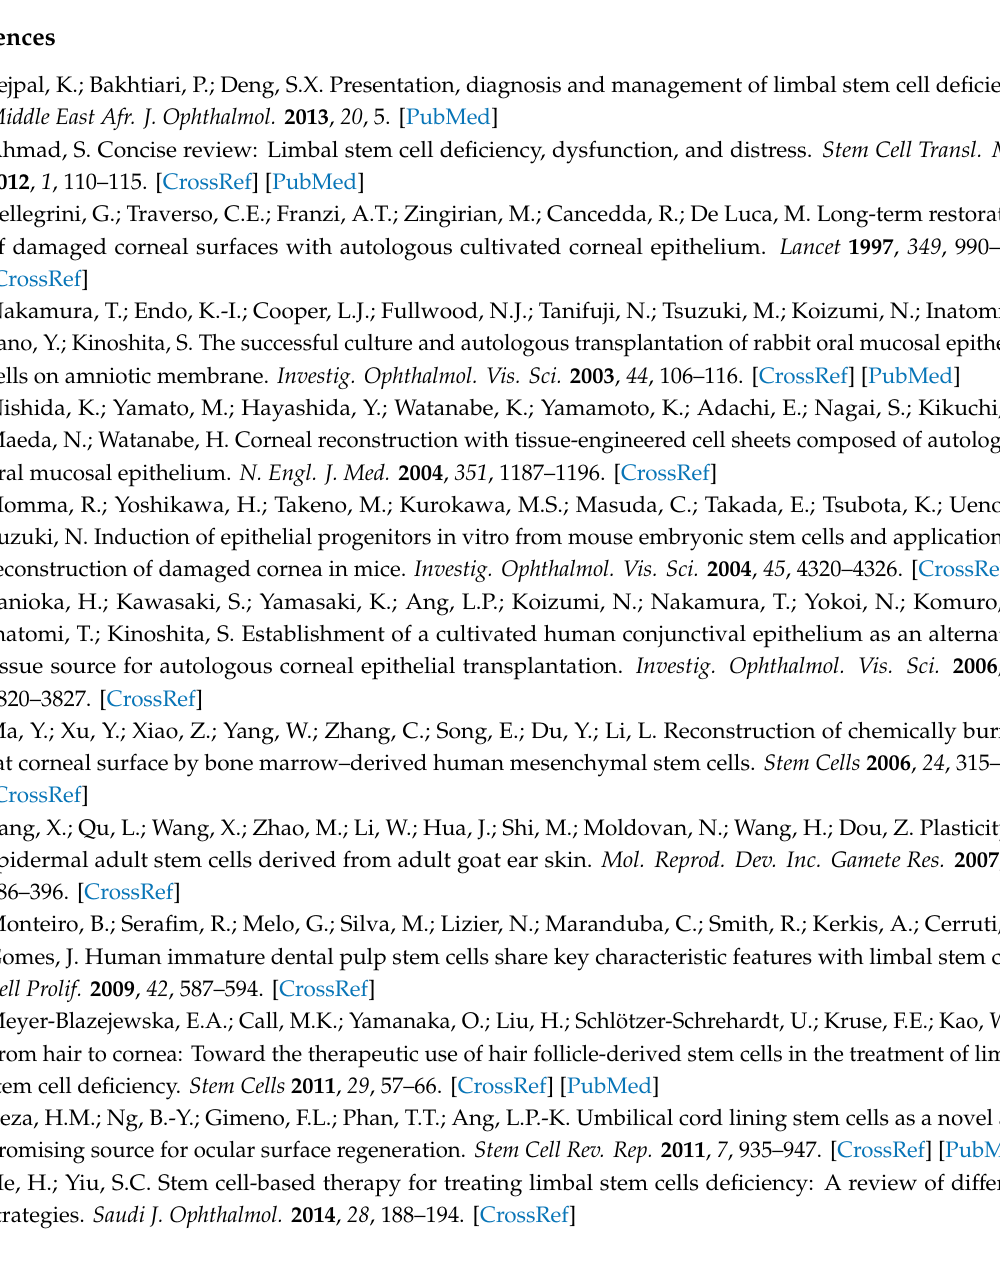
Figure S1: Workflow of experiments; Figure S2: The light microscopic images (4 × magnification) of 1-day old culture of human OMECs on five di ff erent mixtures of HA sca ff old uncoated and coated with 1 mg / mL and 20 µ g / mL collagen IV; Figure S3: The light microscopic images (4 × magnification) of human OMECs after 1, 3, 7, 10 and 14 days of culture on HA sca ff olds dried for 3, 7, 10 or 14 days and coated with 1 mg / mL collagen IV; Figure S4: The light microscopic images (4 × , 10 × , 20 × and 40 × magnification) of human OMECs after 1, 3, 7, 10, 14 and 21 days of culture on HA sca ff old dried for 3 days and coated with 1 mg / mL collagen